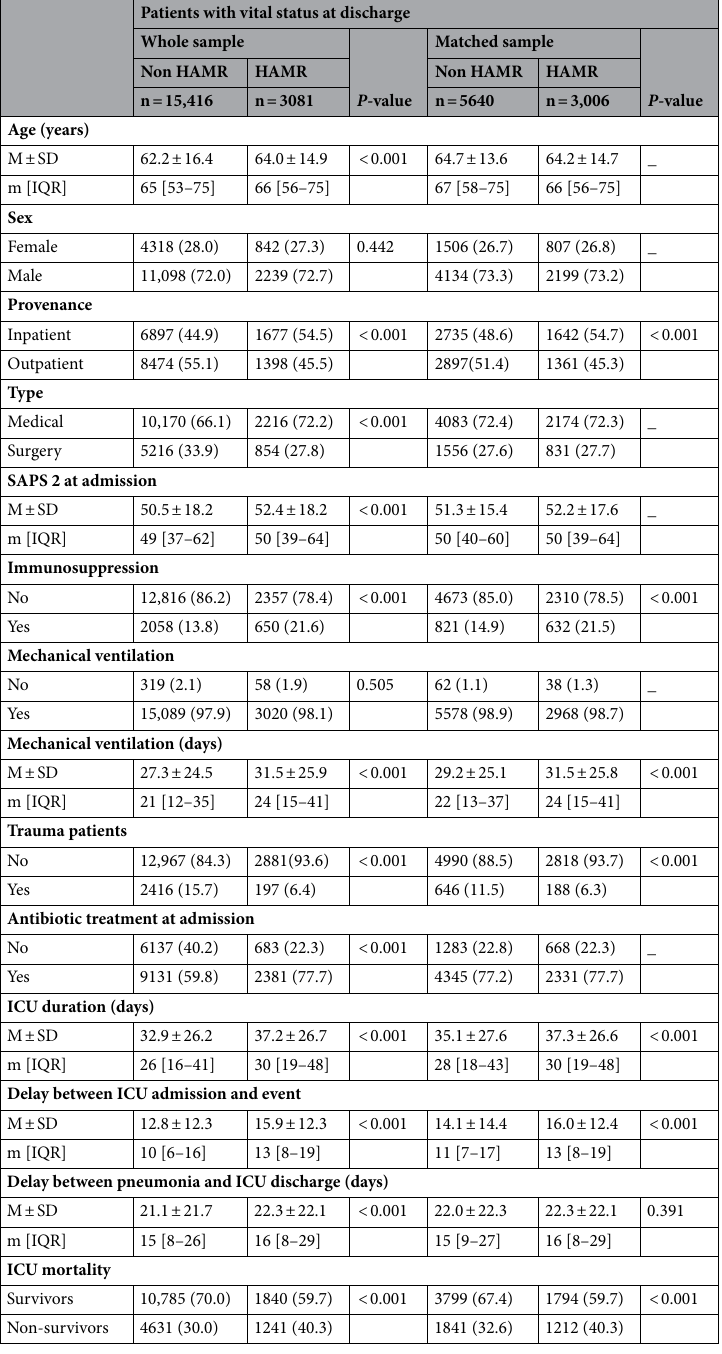
Table 2. Patient characteristics and comparison according to the HAMR status. ICU intensive care unit, HAMR high antimicrobial resistance, SAPS2 simplified acute physiology score. M ± SD: mean ± standard deviation; m [IQR]: median [interquartile range]. *with vital status not